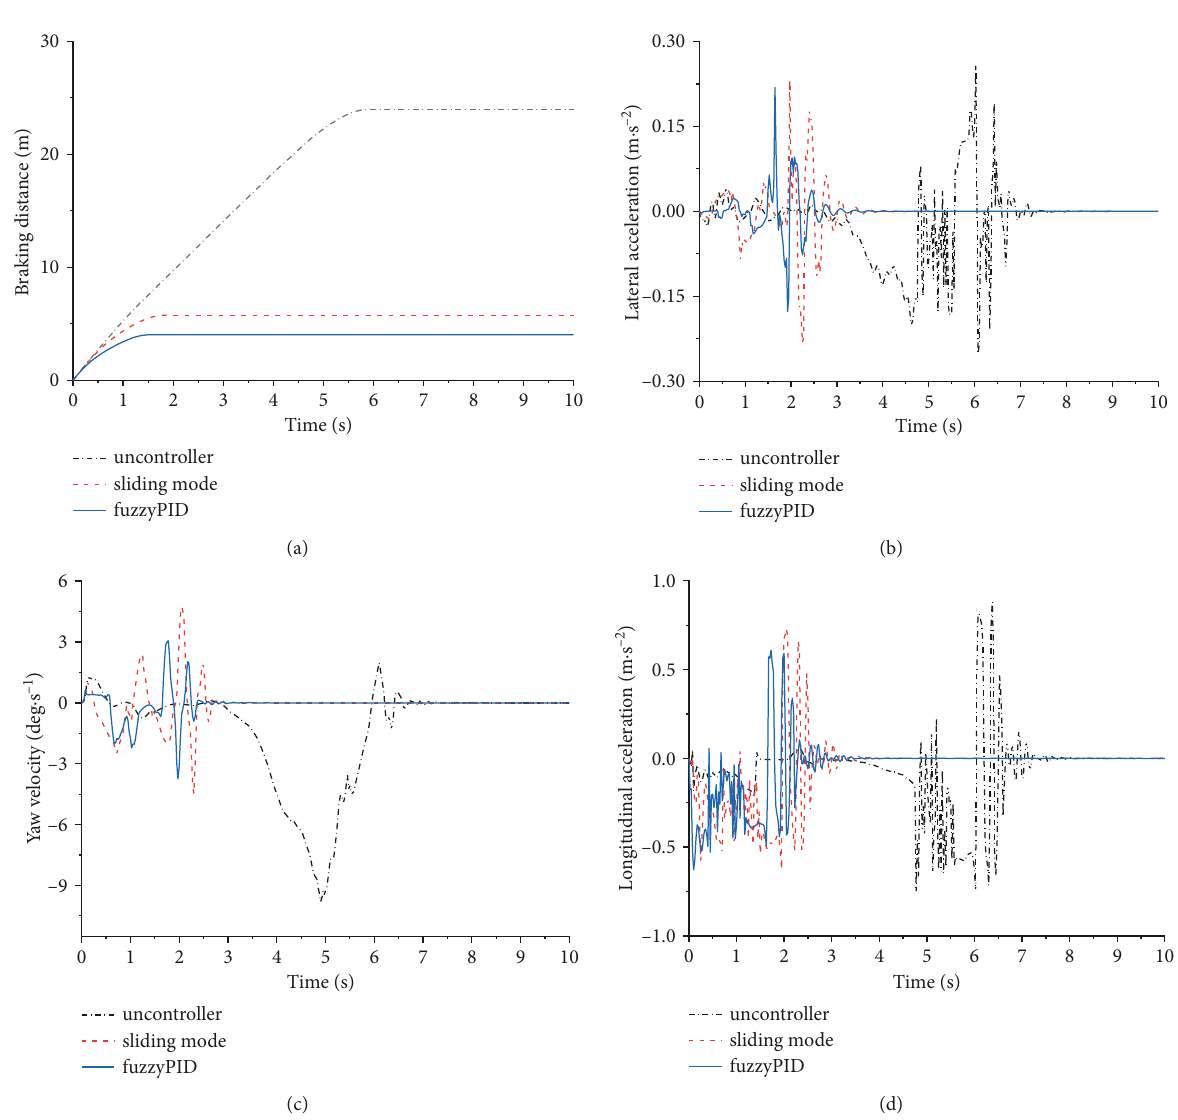
Figure 22: Simulation diagram of curve driving with braking efficiency of 100% at u � 0.75. (a) Braking distance. (b) Lateral acceleration. (c) Yaw velocity. (d) Longitudinal